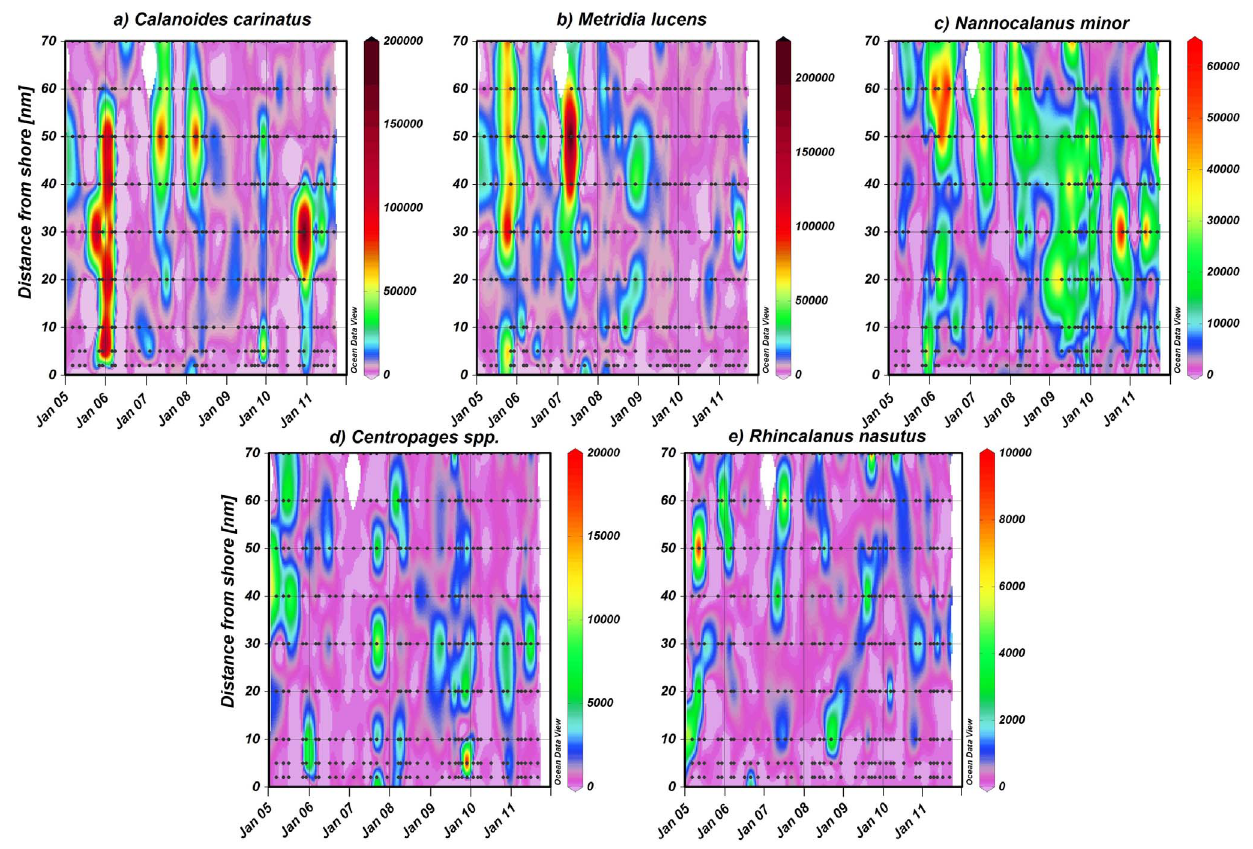
Figure 9. Monthly abundances (no. m 2 2 ) of the dominant copepods a) Calanoidescarinatus , b) Metridialucens , c) Nannocalanusminor, d) Centropages spp. and e) Rhincalanusnasutus along the transect 20 6 S between March 2005 and September 2011. Note different scales.